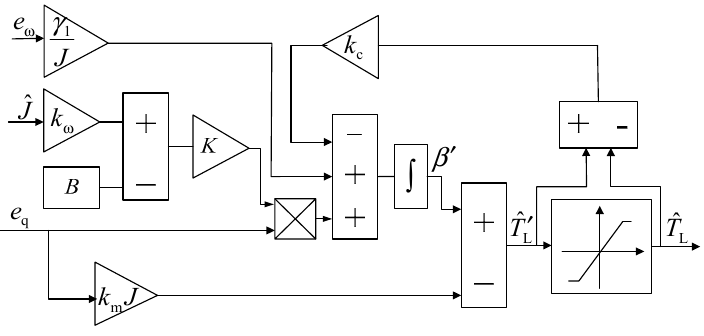
Figure 1. Structure of the anti-saturation torque observer.